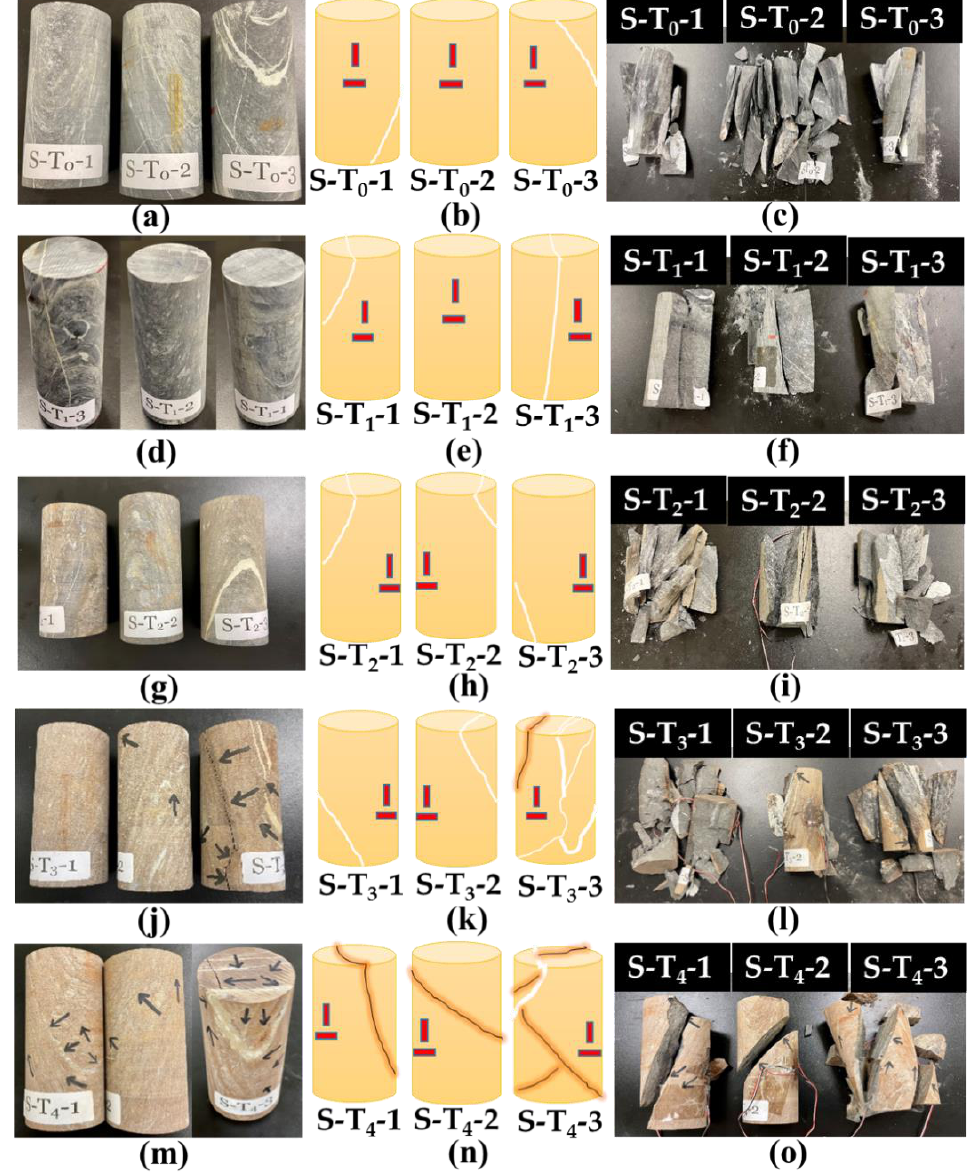
Figure 14. Specimens before and after pressure tests: ( a , c ); specimens before and after UCS testing at 22 °C, ( d , f ); specimens at 200 °C, ( g – i ); specimens at 400 °C, ( j – l ); specimens at 600 °C, ( m – o ); specimens at 800 °C. ( b , e , h , k , n ) represent the schematic specimens with strain gauge (red color), quartz vein (white), crack lines (dark-brown). ( c , f , i , l , o ) represent specimens after pressure tests.